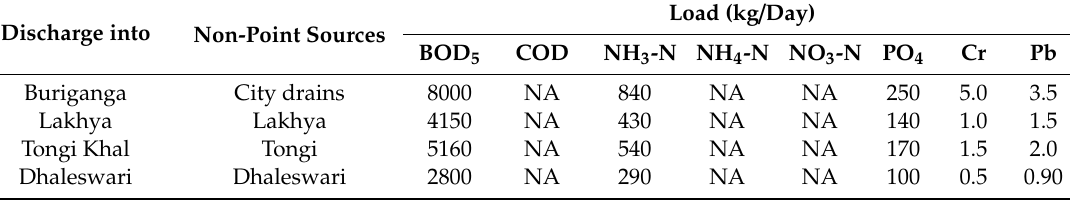
Table A3. Pollution loads contributed by non-point sources estimated using the dry method. Discharge into